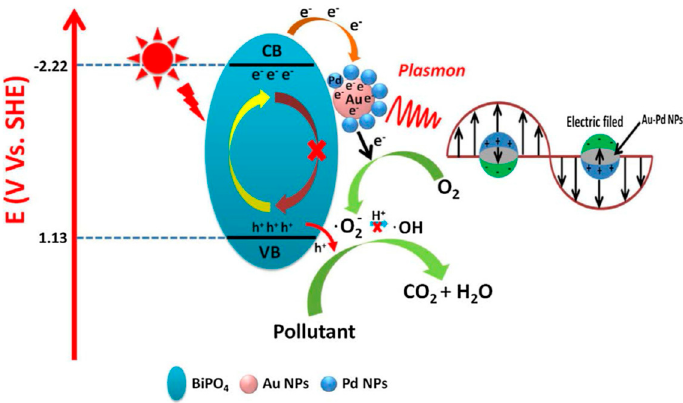
Figure 10. Reaction mechanism of the trichloroethylene oxidation with the Au-Pd / BiPO 4 photocatalyst. Figure from [144]. Copyright 2017, Elsevier.